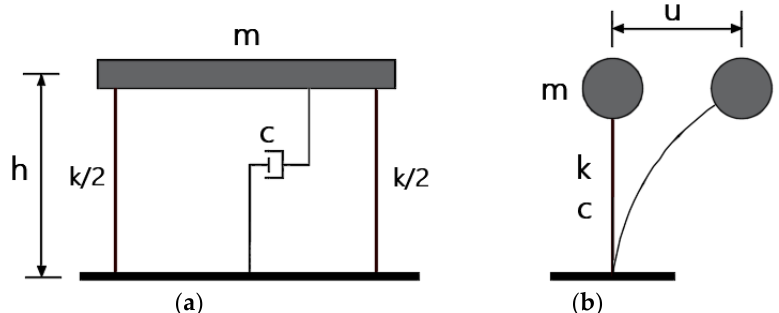
Figure 2. ( a ) Structural building model; and ( b ) the idealized SDOF mathematical model.